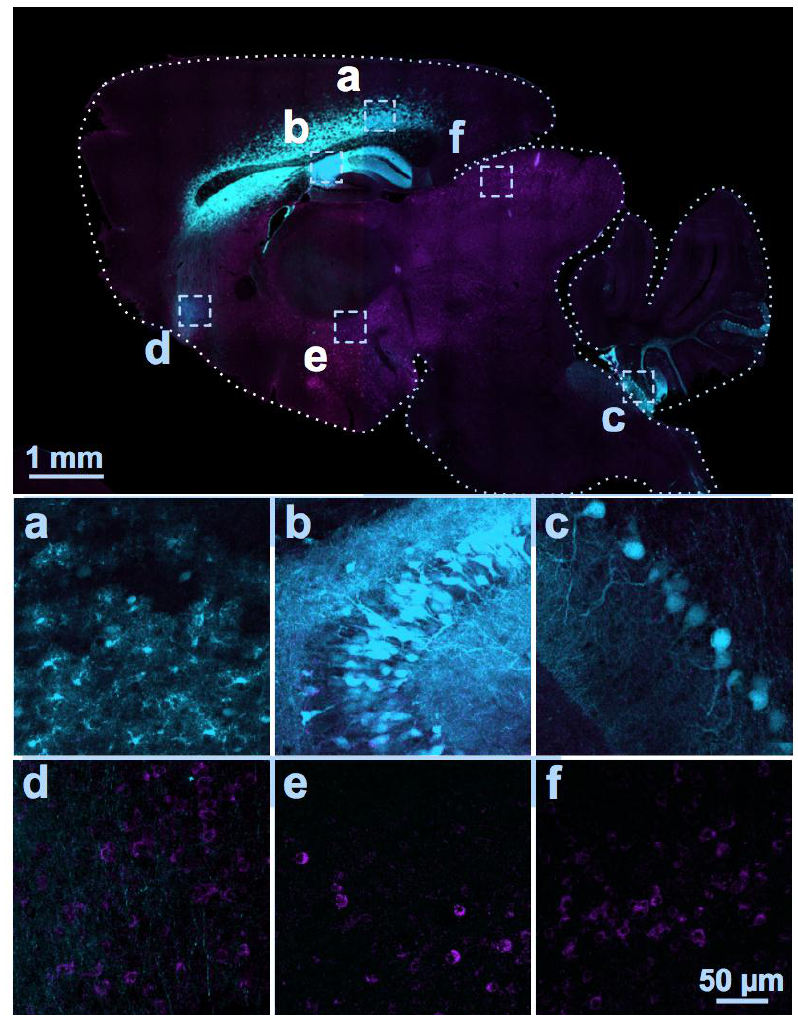
Figure 1. Distribution of AAV serotype 9-mediated transgenes following an i.c.v. and i.c.m. double injection. Two different AAV vectors were injected into a C57BL/6J mouse at Postnatal Day 2. One encoding a cytomegalovirus promoter driving enhanced green fluorescent protein (eGFP; visible in cyan color; dose: 2 × 10 10 GC) was injected bilaterally into the lateral ventricles (i.c.v.); the other using a GABAergic neuron promoter driving a myc-tagged sodium channel protein was injected into the cisterna magna (i.c.m., visible as magenta color; dose: 3 × 10 10 GC). At Postnatal Day 18, the distributions of the two proteins were examined in sagittal sections of fixed brain tissue using immunocytochemistry and anti-c-myc and anti-green fluorescent protein (GFP) antibodies. GFP immunolabeling was detected in the cerebral cortex ( a ), hippocampus ( b ), and Lobules VII to X of the cerebellum ( c ), while the myc-tagged protein was expressed in soma and eGFP was expressed in axons in the frontal regions of the brain ( d ), hypothalamus, ( e ), and the inferior colliculus ( f ). Thus, the two vectors administered into the CSF at the same time by two different injection routes were largely distributed in distinct brain